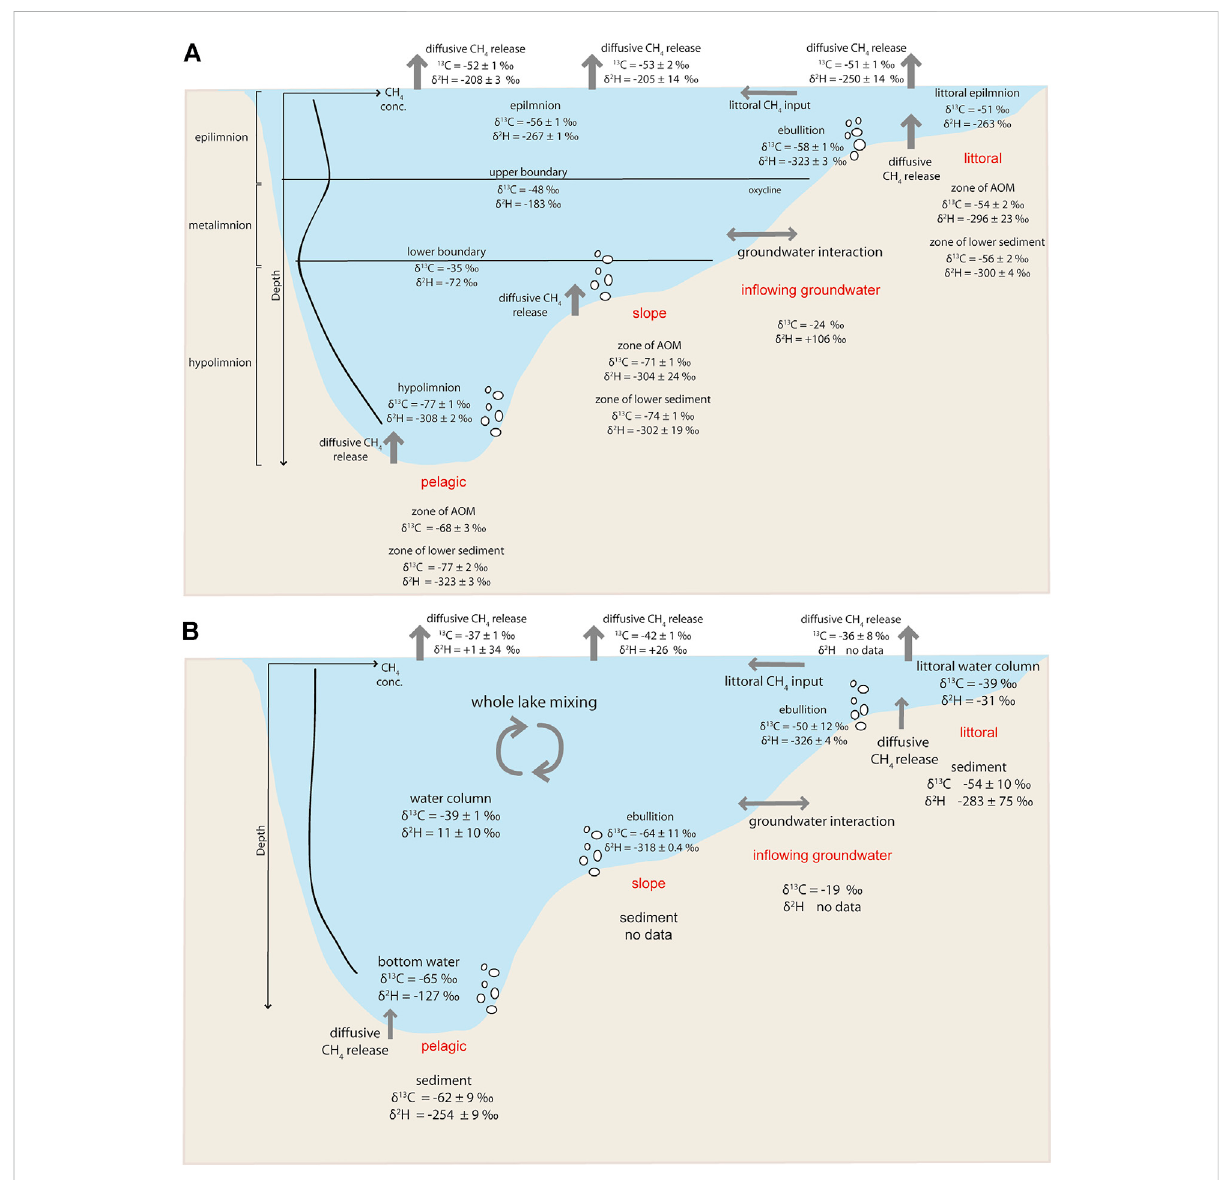
FIGURE 8 Methane cycling in Lake Willersinnweiher showing CH 4 sources and sinks with δ 13 C-CH 4 and δ 2 H-CH 4 values (where available) as well as transportmechanisms(grey)ofdifferentwaterlayers(black)observedatthethreeinvestigatedsitesduring (A) thestrati fi cationperiod(July2020,for diffusive release at water-air interface data from July 2021 is shown and for ebullition data from September 2021) and (B) the mixing period (March 2021 and for ebullition data from November 2020 is